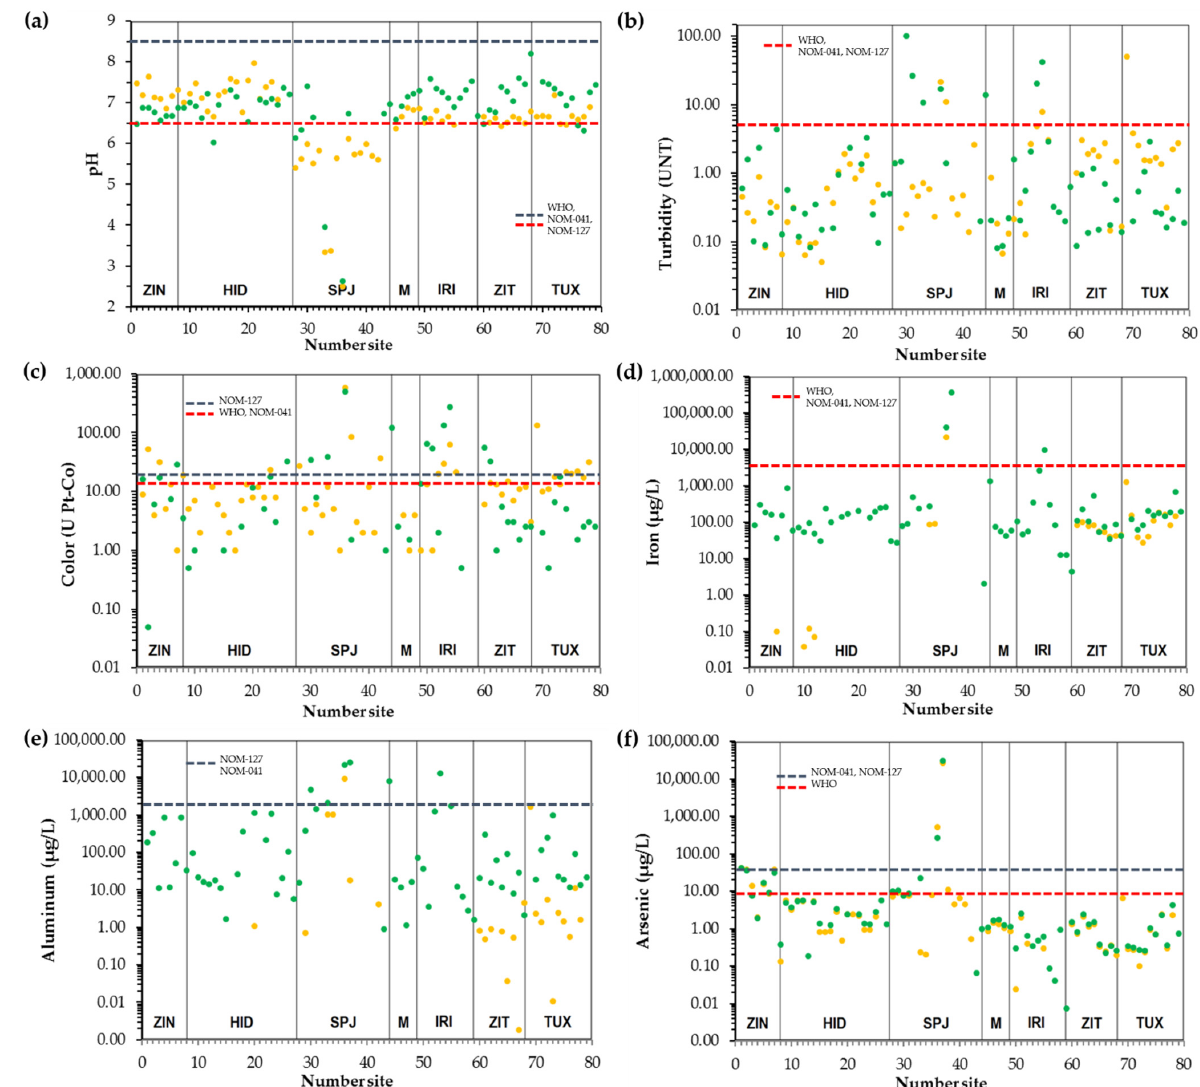
Figure 2. Quality parameters of drinking water supply sources for humans in the regions of study that stood out due to higher levels concerning the permissible limits defined by WHO, NOM-040, and NOM-127: ( a ) pH; ( b ) turbidity; ( c ) color; ( d ) iron; ( e ) aluminum; ( f ) arsenic. Green dots ( • ): rainy season, yellow dots ( • ): dry season. Vertical lines on the secondary x-axis represent the distribution of each municipality.